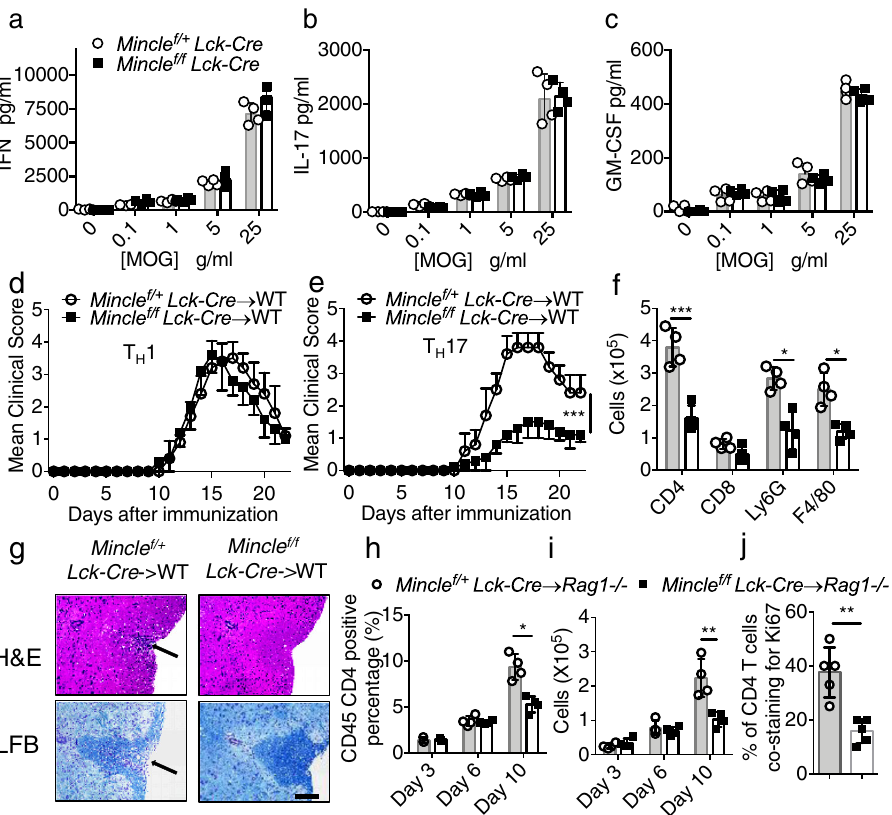
Fig. 3 Mincle is required for T H 17 mediated EAE progression. a – c Lymph nodes were harvested from MOG immunized mice on Day 9 post immunization, and cells were cultured with increasing concentrations of MOG for 72 h. Cytokine concentrations in the culture media were measured by ELISA, n = 4 biological replicates. d , e Mean clinical score of EAE mice ( n = 5) induced by adoptive transfer of MOG-reactive d T H 1 or e T H 17 cells. f Brain lymphocytes from T H 17 recipient mice were harvested at the peak of disease and analyzed by fl ow cytometry with indicated antibodies by fl ow cytometry, n = 5 biological replicates. g H&E staining and Luxol fast blue staining of lumbar spinal cords at peak of the disease in recipient mice. Scale bar, 100 μ M. Arrows in the upper panel indicate in fl ammatory cells in fi ltration, and arrows in the lower panel indicate demyelination area. Representative data are shown for n = 4. h Percentage of CD45 + CD4 + cells of total CNS in fi ltrated cells from Rag1 − / − mice that received MOG-reactive T H 17 cells, n = 4 biological replicates. i Cell numbers of CNS-in fi ltrating CD4 + T cells from ( h , j ). Percent of Ki67/CD4 double-positive cells from spinal cords from adoptive transfer experiments 9 days after transfer (representative images shown in Supplemental Fig. 3f.). n = 5, biological replicates. ** P < 0.01 (Two-sided student ’ s t test for a – c , f , h – j ). *** P < 0.001 (two-way ANOVA for d , e ). Data are represented as mean ± SD. Exact P values for asterisks (from left to right): e